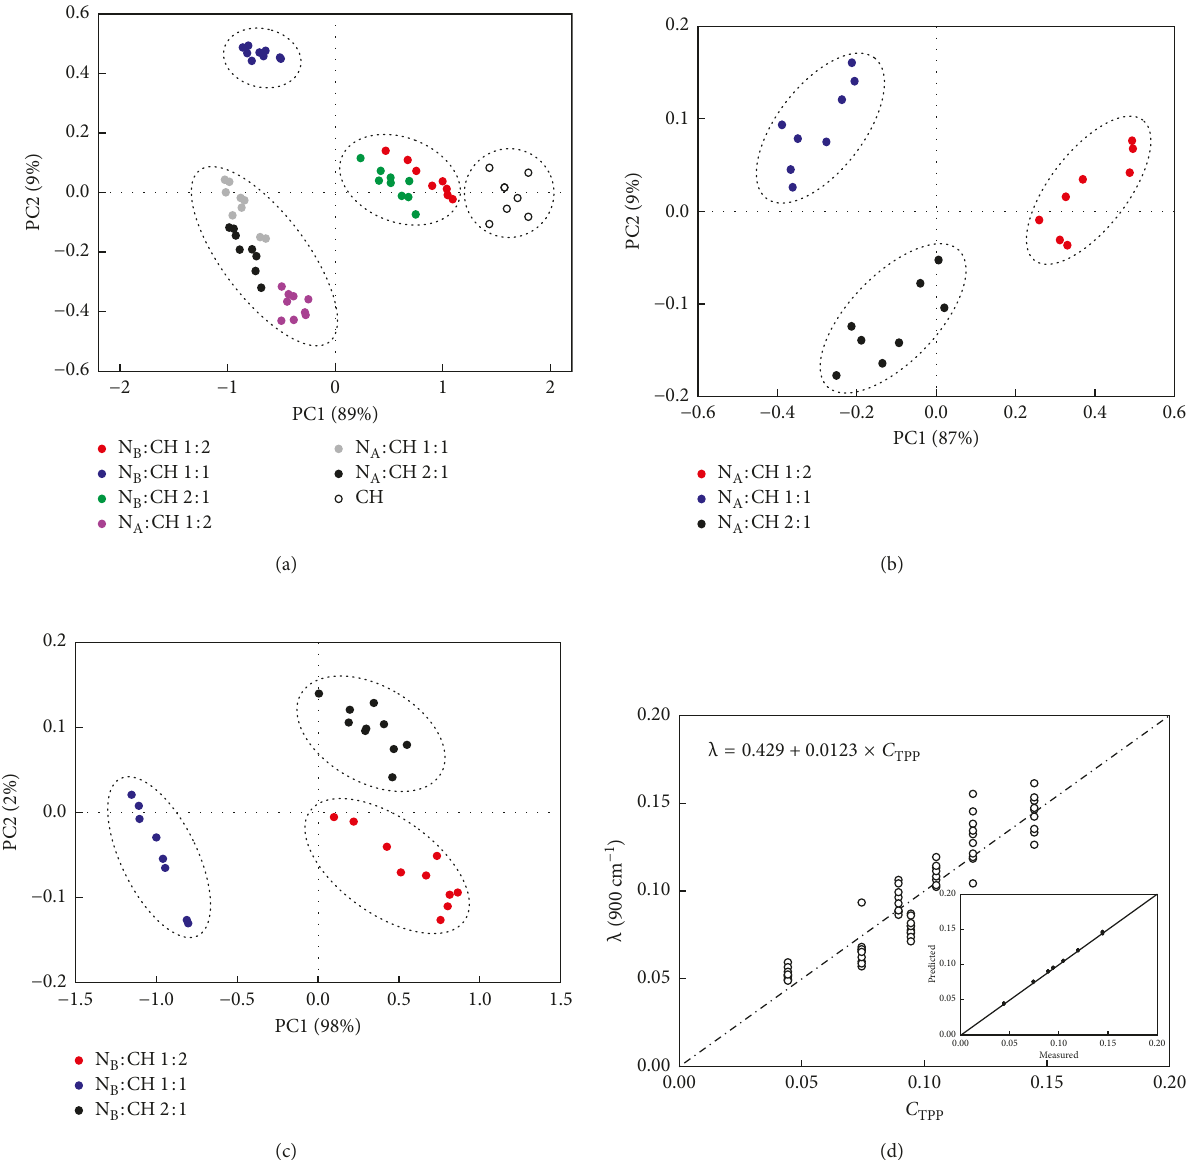
1 (a). PCA score plots show the cluster Figure 6: PCA biplot of CH and nanocomposite matrices in the ATR-FTIR region 1700–1400cm distribution of nanocomposites formulated with different N:CH ratios for N A (b) and N B (c). Correlation between the absorbance − 1 and the concentration of tripolyphosphate ( C corresponding to 900cm TPP ) obtained from PLS model (d). Figure inserted in figure (d) shows predicted versus measured −